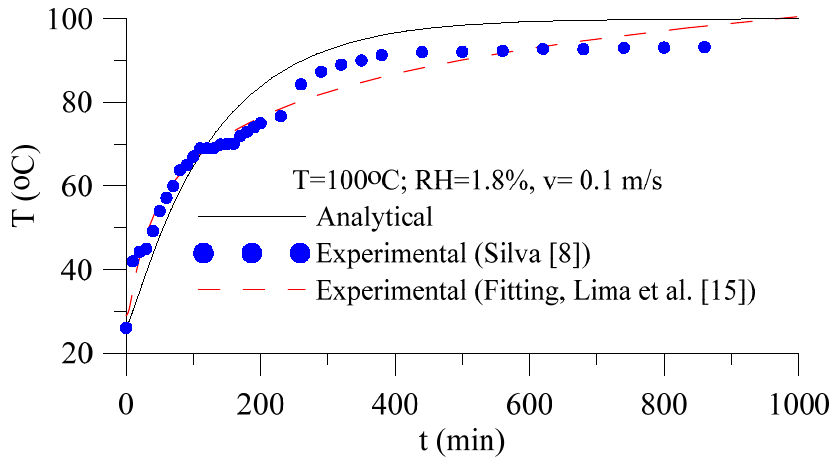
Figure 6. Comparison between predicted and experimental surface temperature (vertex) during the drying process of industrial hollow ceramic bricks.